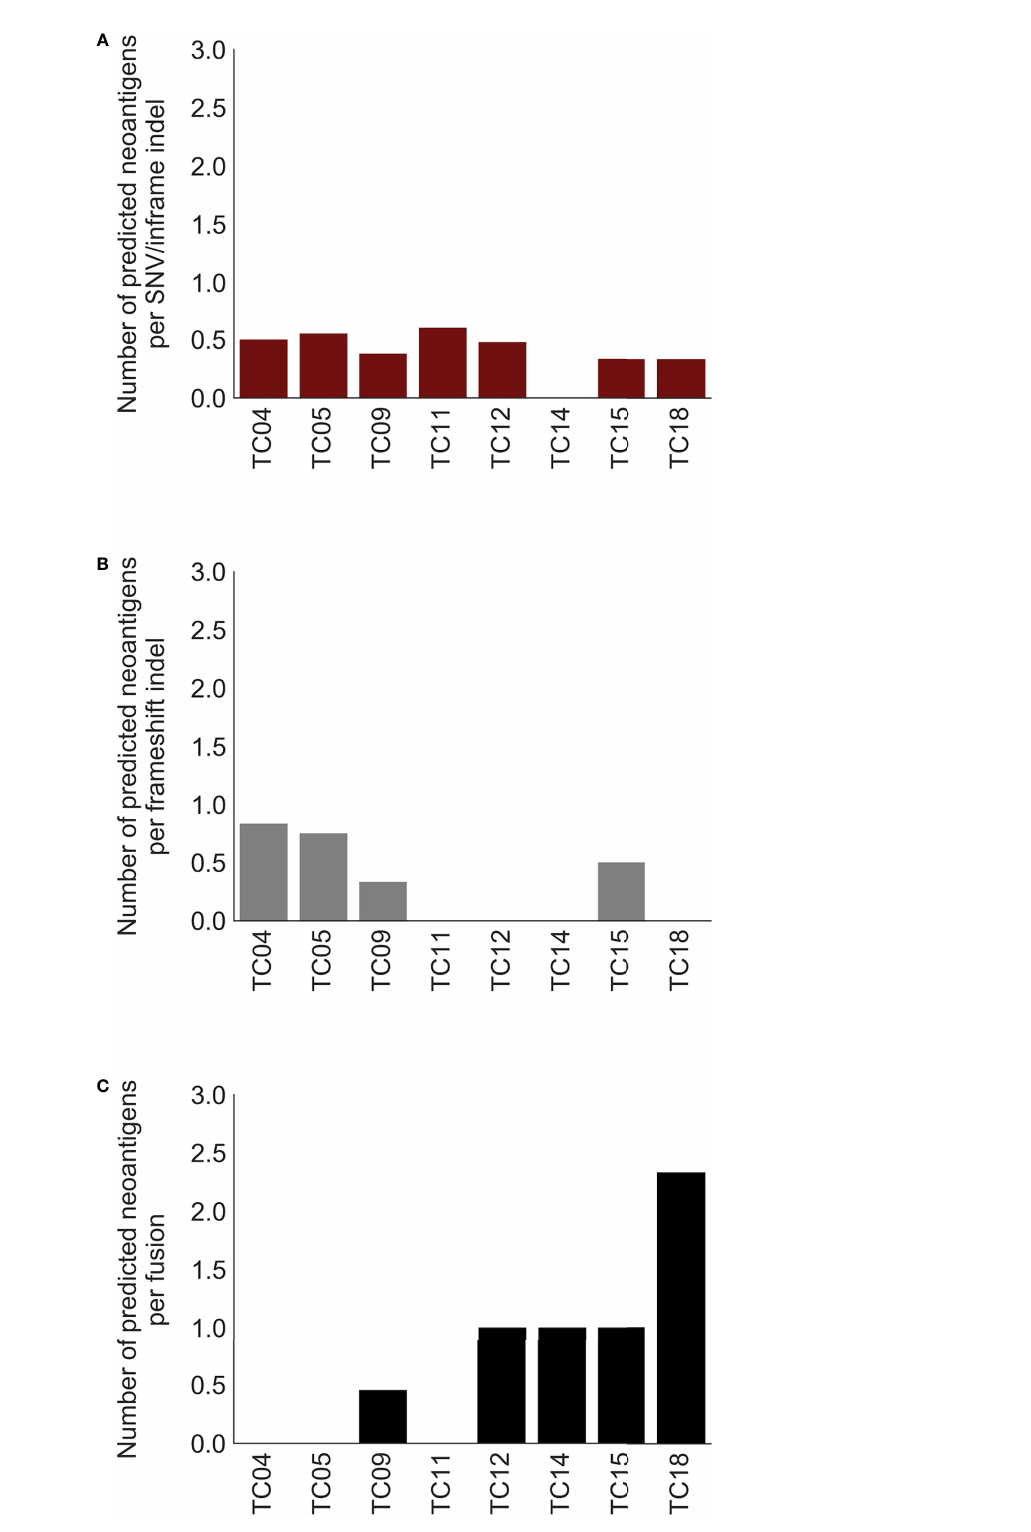
FIGURE 4 | Comparison of predicted neoantigen candidates produced by three types of alterations. Bar charts of the number of predicted neoantigens per (A) SNV/inframe indel, (B) frameshift indel, and (C) fusion. X-axis: thymic carcinoma patients with both paired DNA and RNA